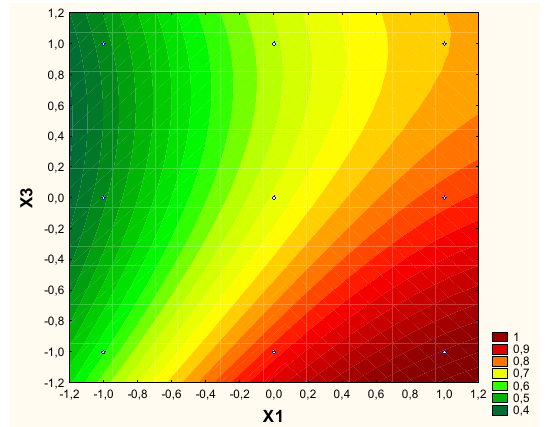
Figure 4. Interaction between drug concentration and concentration X of enhancer ( X 1 3